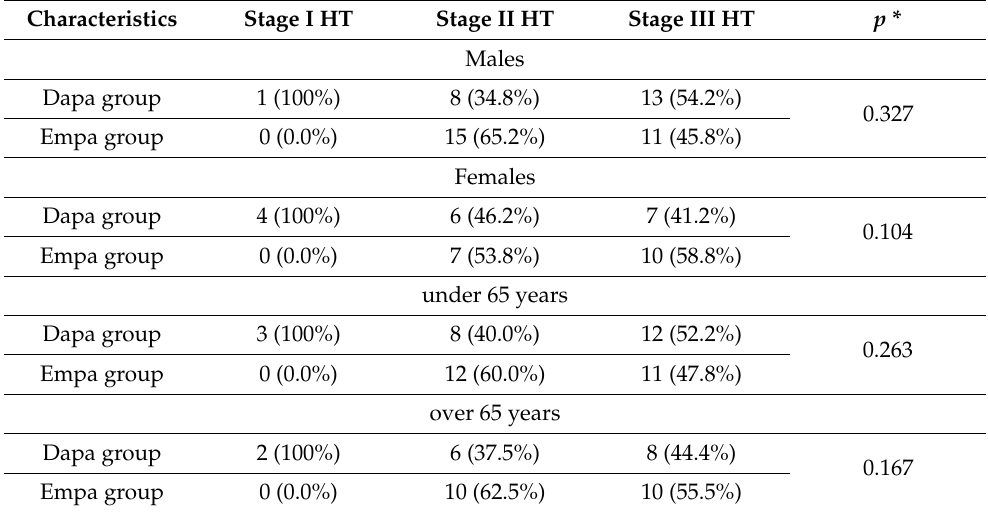
Table 3. Correlation of demographic characteristics with HT compared to groups studied.